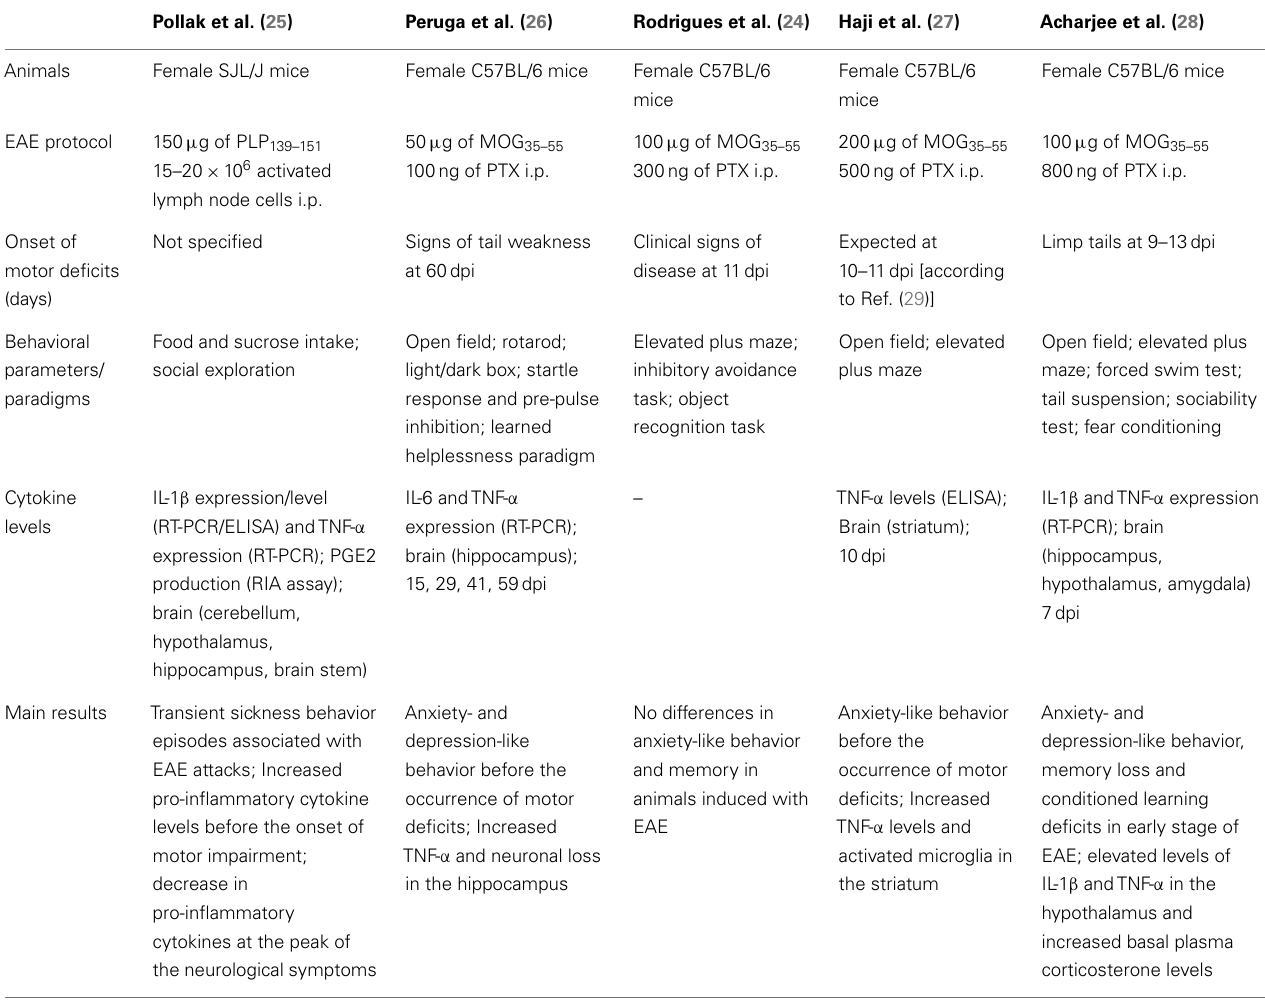
Table 1 | Previous studies characterizing behavioral changes in mouse models of EAE